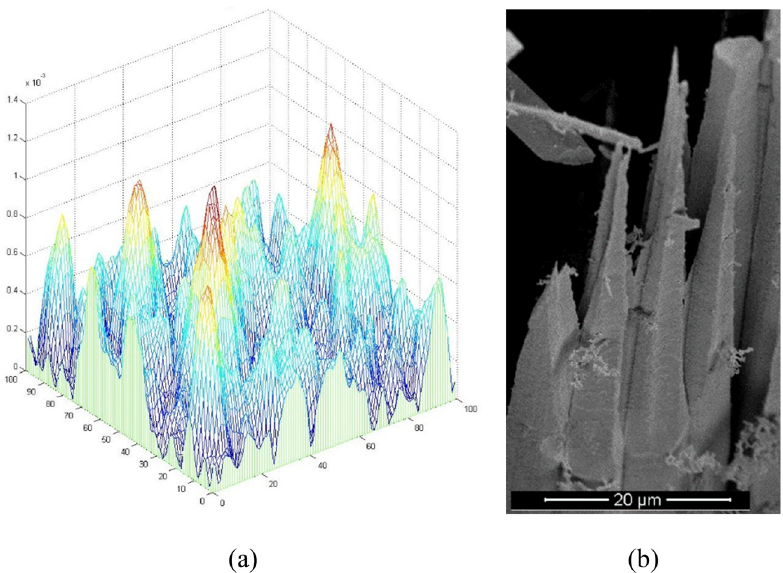
Figure 9: Morphologies of the oxidized fi ber bundles: ( a ) simulation and ( b )